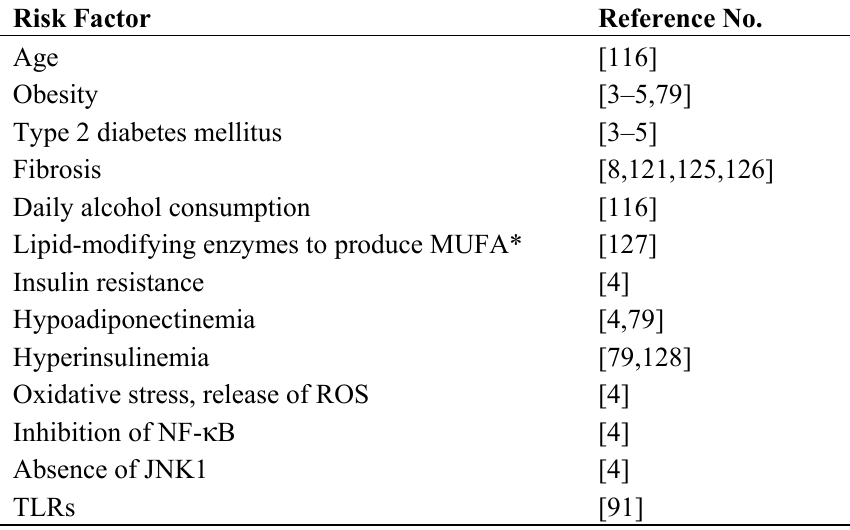
Table 2. Risk factors involved in carcinogenesis of